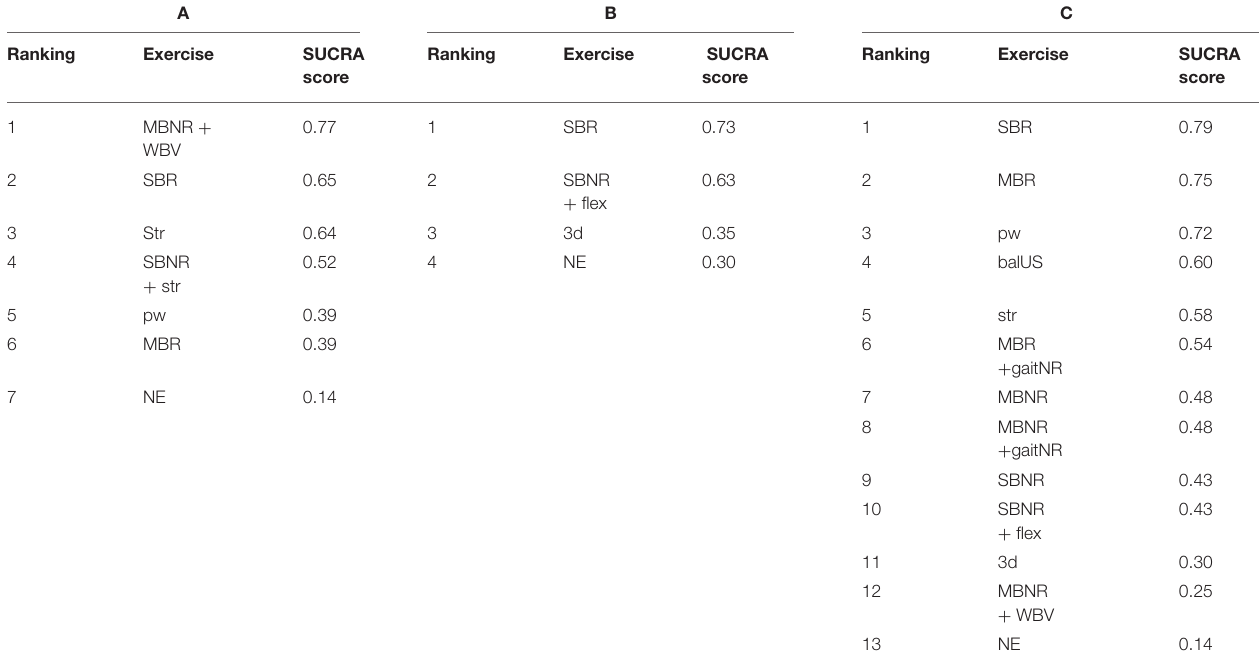
TABLE 6 | Ranking of exercise interventions in each reactive balance outcome category. A B C Ranking